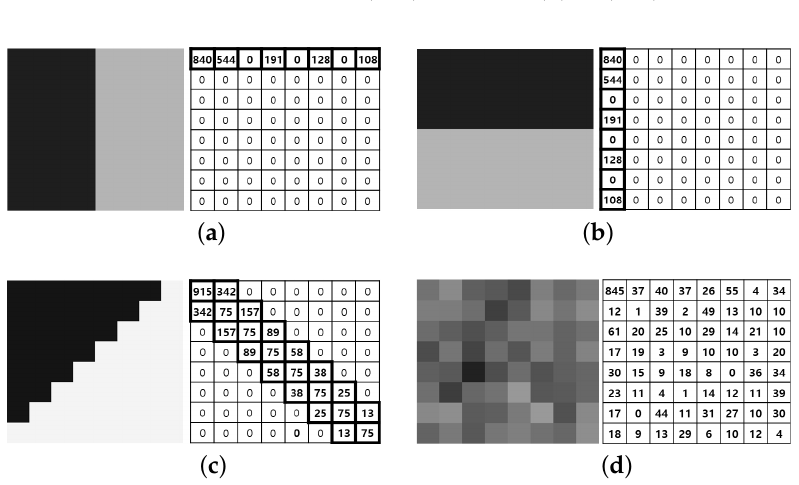
Figure 3. DCT energy distribution of edge and texture images. ( a ) DCT energy distribution of vertical edge. ( b ) DCT energy distribution of horizontal edge. ( c ) DCT energy distribution of diagonal edge. ( d ) DCT energy distribution of non-directional